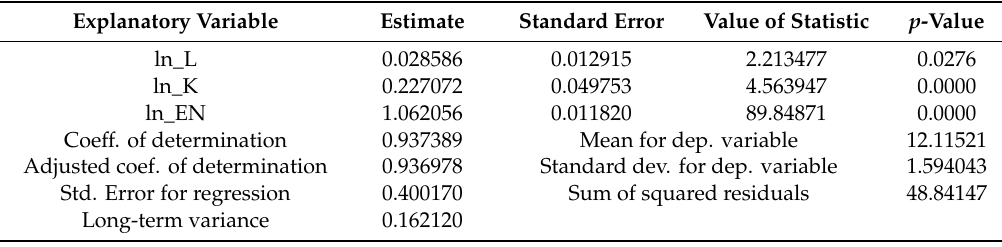
Table 4. Panel data model based on FMOLS estimators to explain output growth in the EU countries and UK